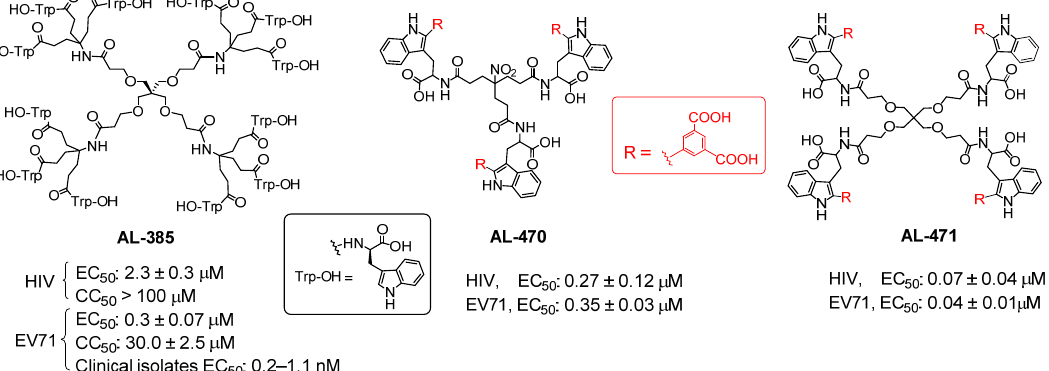
Figure 1. Structure of dendrimer AL-385 and reduced-sized prototypes AL-470 and